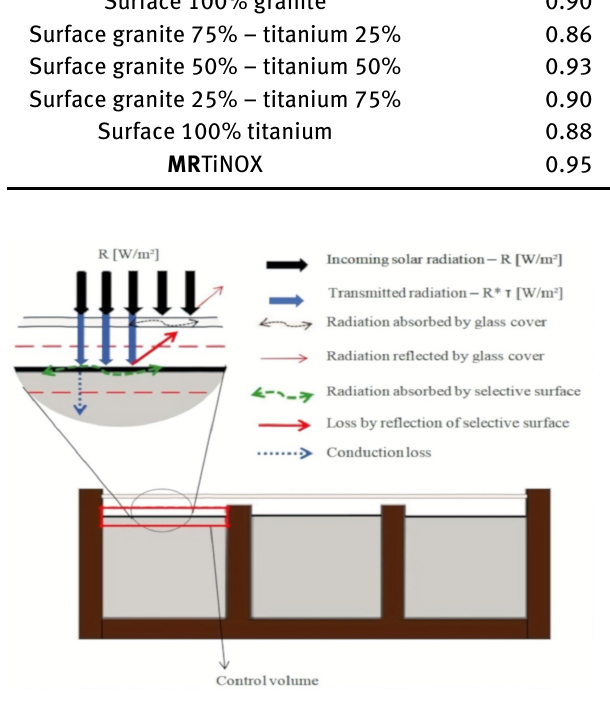
Figure 10: Test bench energy balance for operation of selective surfaces in the sun